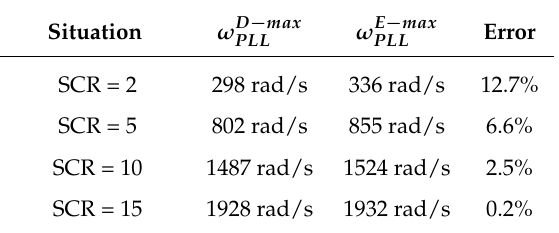
Table 2. Errors of the eigenvalue-based impedance stability analysis in terms of various SCRs.